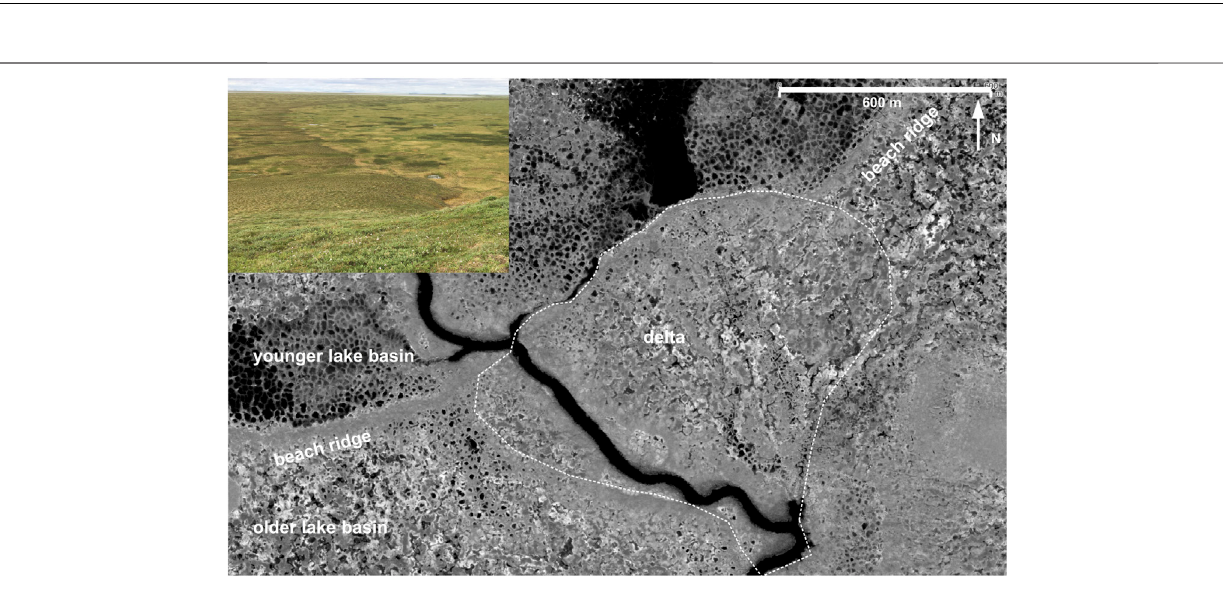
Frontiers in Earth Science |